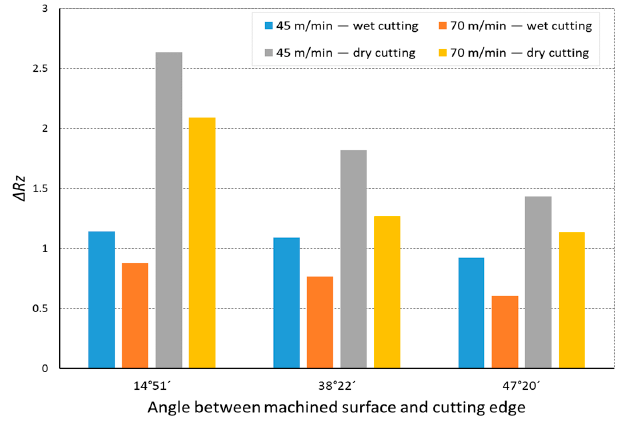
Figure 13. The impact of angle between the machined surface and cutting edge on ratio ∆ Rz of the average measured surface roughness height to the theoretical surface roughness Rz to for a curvilinear track and 23 HRC.